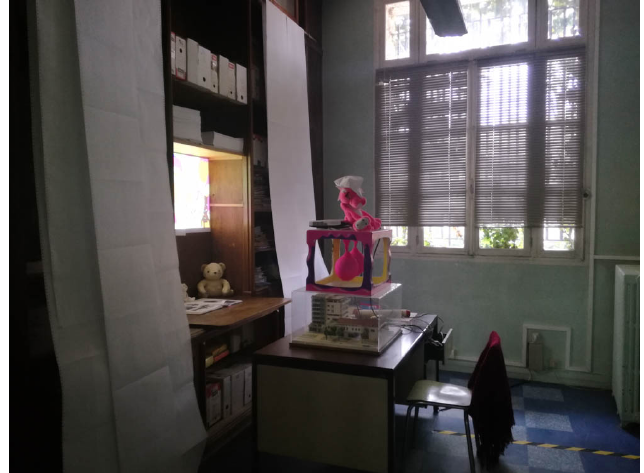
Figure 4. The installation of Huge balls version.2 in Malakoniarof